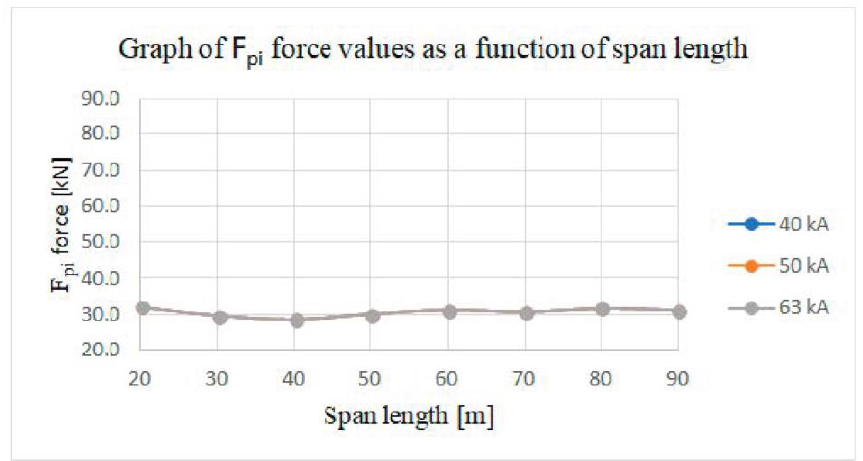
Figure 8. Graph of the value of the force F pi as a function of the span length.